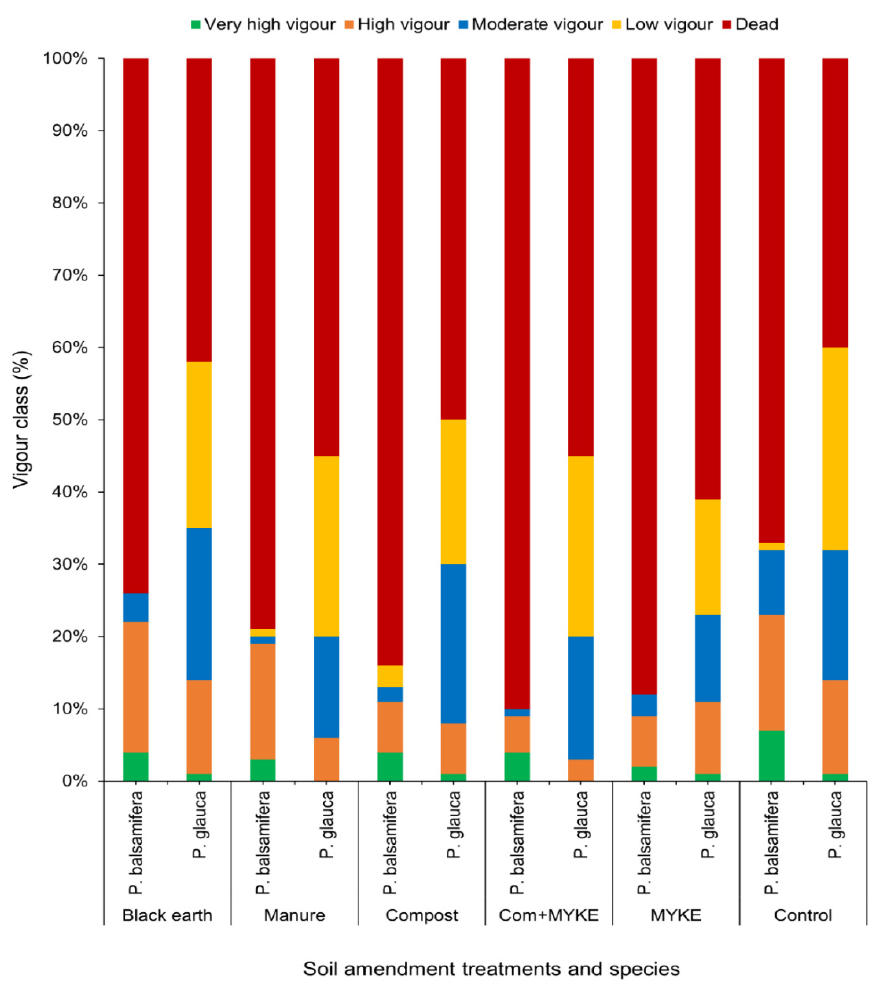
Figure 2. Vigor class percentages of planted P. glauca and P. balsamifera by soil amendment treatments.